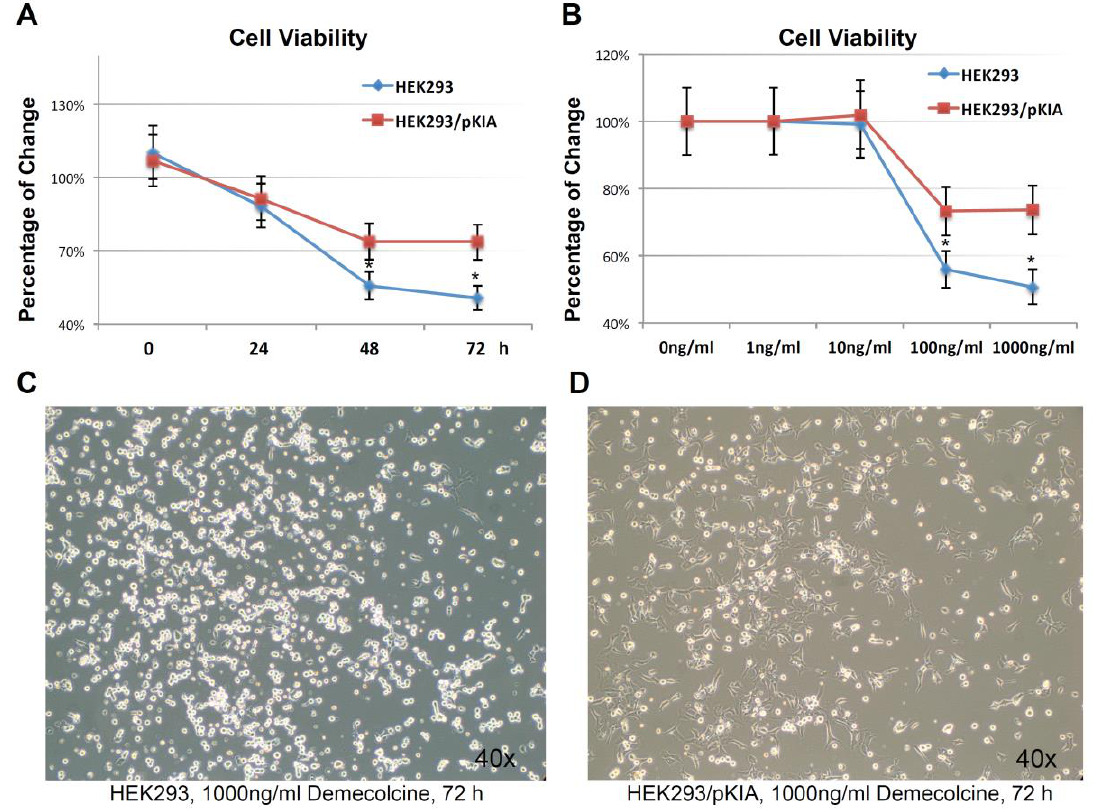
Figure 7. Over-expressing KIAA0100 increases tolerance to microtubule targeted drug. ( A ) HEK293 and HEK293/pKIA cells were seed in 96 well with Demecolcine concentration ranging from 1 ng/mL to 1000 ng/mL, cell viability were examined from 0 (DMSO only) to 72 h. cell viability for HEK293/pKIA at higher dose of Demecolcine (100 and 1000 ng/mL) were significantly higher than the corresponding HEK293 cells (*, p < 0.05); ( B ) at 1000 ng/mL Demecolcine treatment, viability of both cells start to decrease at 48 h after treatment, but HEK293/pKIA show significant higher viability compared to HEK293 (*, p < 0.05); phase contrast microscope image of ( C ) HEK293 and ( D ) HEK293/pKIA cells treated with 1000 ng/mL Demecolcine at 72 h after treatment. Most HEK293 cells detached from the plate surface and appeared as round shape. In contrast, though some HEK293/pKIA cells also become round shape, most of the cell were still well attached to the plate surface and well spread.